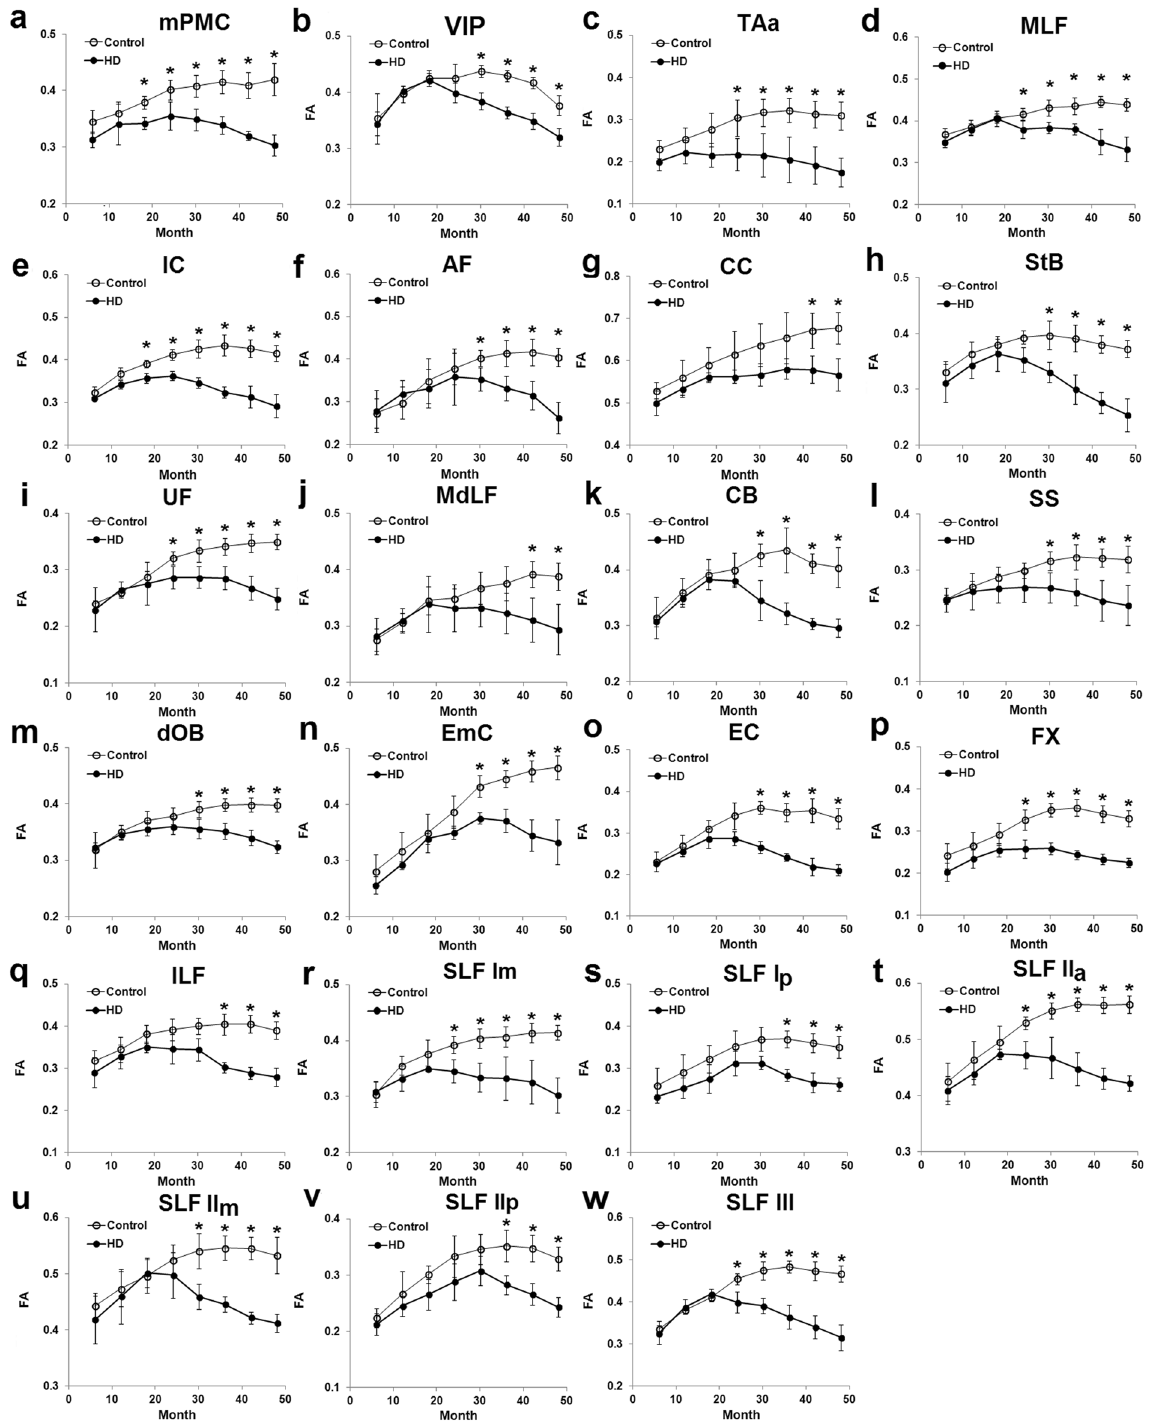
Figure 4. The averaged FA values in all ROIs at each age for both groups as determined by TBSS. The star ( * ) shows significant group difference at the specific age ( * p < 0.05; details are shown in Tables 3 and 4). FA: fractional